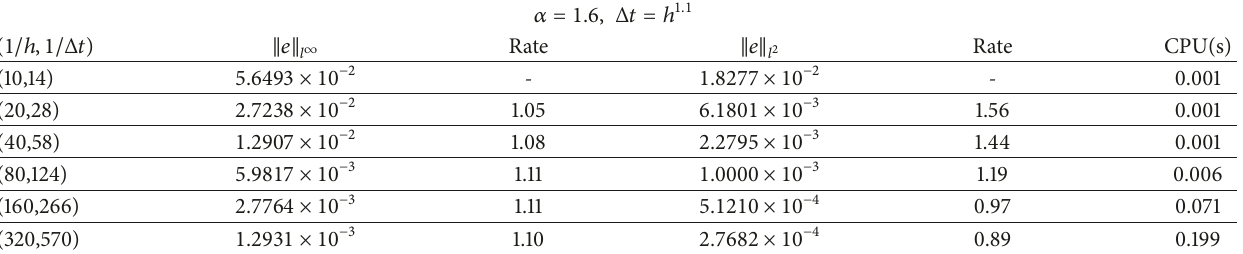
Table 11: Error and convergence rates for Example 2 by [19].